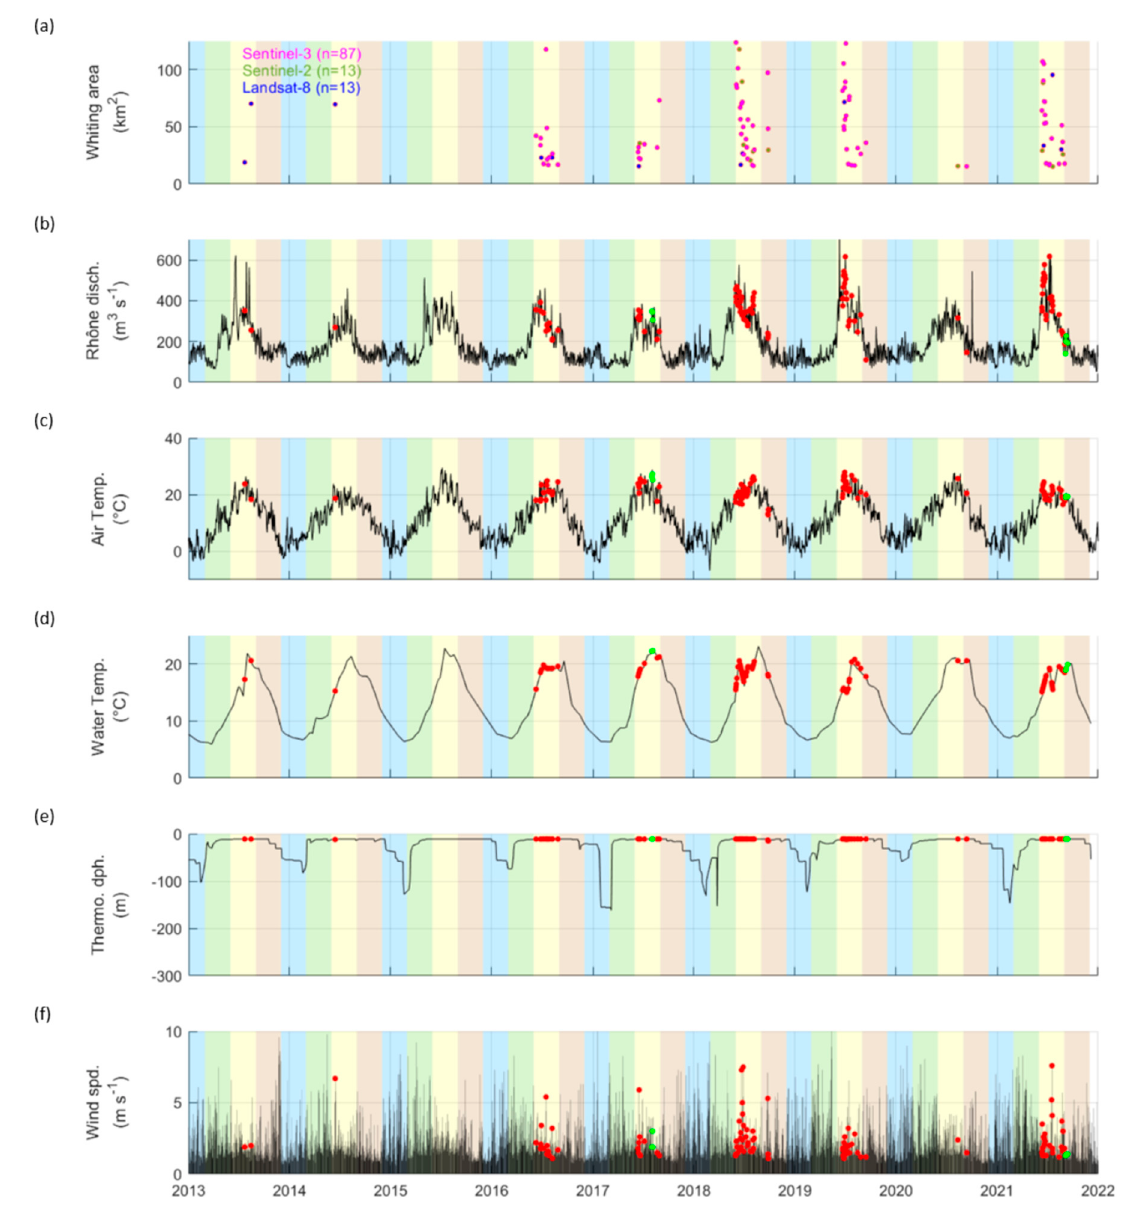
Figure 5. ( a ) Whitings area as seen by the three satellites that detected events > 15 km 2 . Landsat-8 images are shown in blue, Sentinel-2 in green, and Sentinel-3 in magenta. ( b ) Rhone River discharge, ( c ) air temperature (monitored at noon), ( d ) surface water temperature (0–10 m depth), ( e ) thermocline depth at the SHL2 monitoring point, and ( f ) wind speed. Shaded areas highlight the different seasons (blue for winter, green for spring, yellow for summer, and brown for fall). The occurrence of class 1 (class 2) whiting days is shown in red (green) on ( b – f ). Table 2. Averaged environmental conditions during observed whiting days from 2013 to 2021 (> 15 km 2 ) in Lake Geneva. The standard deviations for each condition are also specified. The number of whiting days for each class is specified. Parameter (unit) Class 1 (Mean +/ − Std.) Class 2 (Mean +/ − Std.) Rhone discharge (m 3 s − 1 ) 363.1 +/ − 102.9 251.1 +/ − 81.4